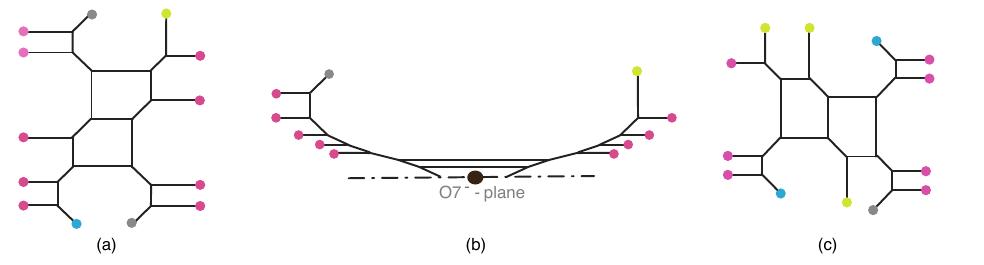
Figure 6 . Mass decoupling limit. (a) SU(3) 1 Sp(2) theory with N f = 9 (cid:13)avors and k = 0; (c) [3]